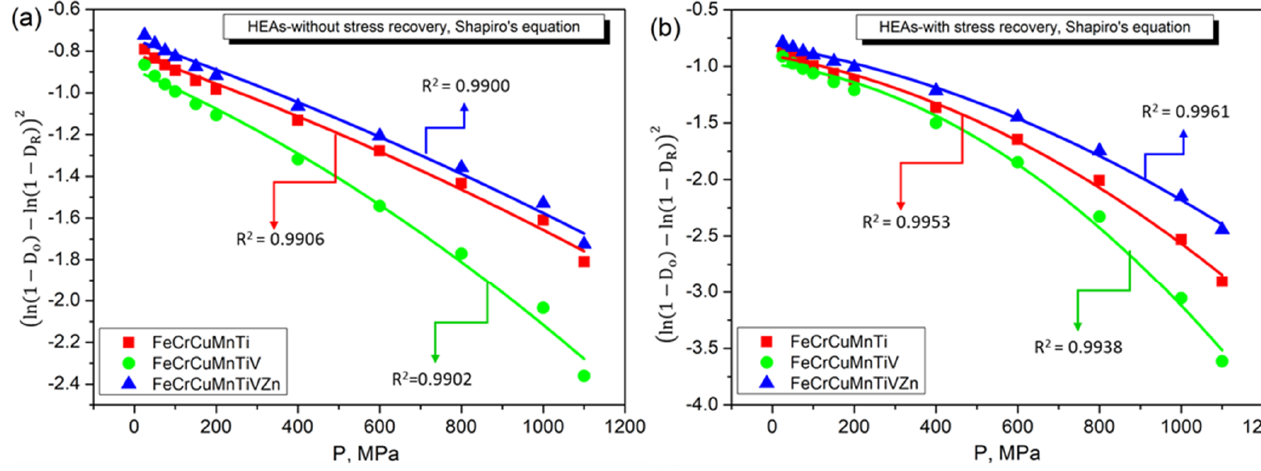
Figure 12. Densification behavior fitted by various non-linear models for the three developed nanostructured HEAs for as-milled and stress recovered conditions: ( a , b ) Shapiro’s Equation (11); ( c , d ) Cooper and Eaton’s Equation (12); ( e , f ) Van Der Zwan and Sisken’s Equation (13). 4. Discussion Three nanostructured HEAs, namely, FeCrCuMnTi (HEA1), FeCrCuMnTiV (HEA2), and FeCrCuMnTiVZn (HEA3) were synthesized by MA at 25 h in this study. The solid solution formation of each alloy was confirmed by XRD patterns (Figure 2) and the higher magnification of the HRSEM images (Figures 4 and 6) represents the presence of BCC, FCC, and HCP phases. FCC was found to be the major phase in each alloy. The densifica- tion behavior of the developed HEAs was highly influenced by the incorporated elements,